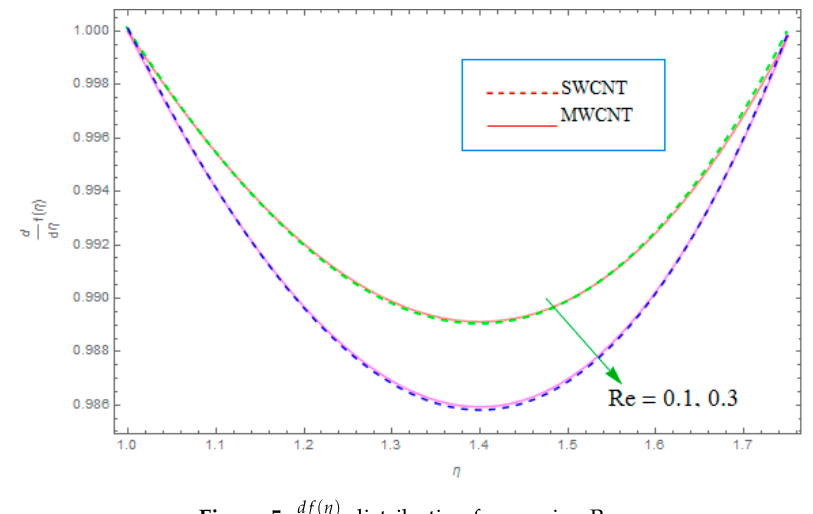
η ( ) df Figure 5. df ( η ) distribution for varying d η Figure 5. distribution for varying Re . η d